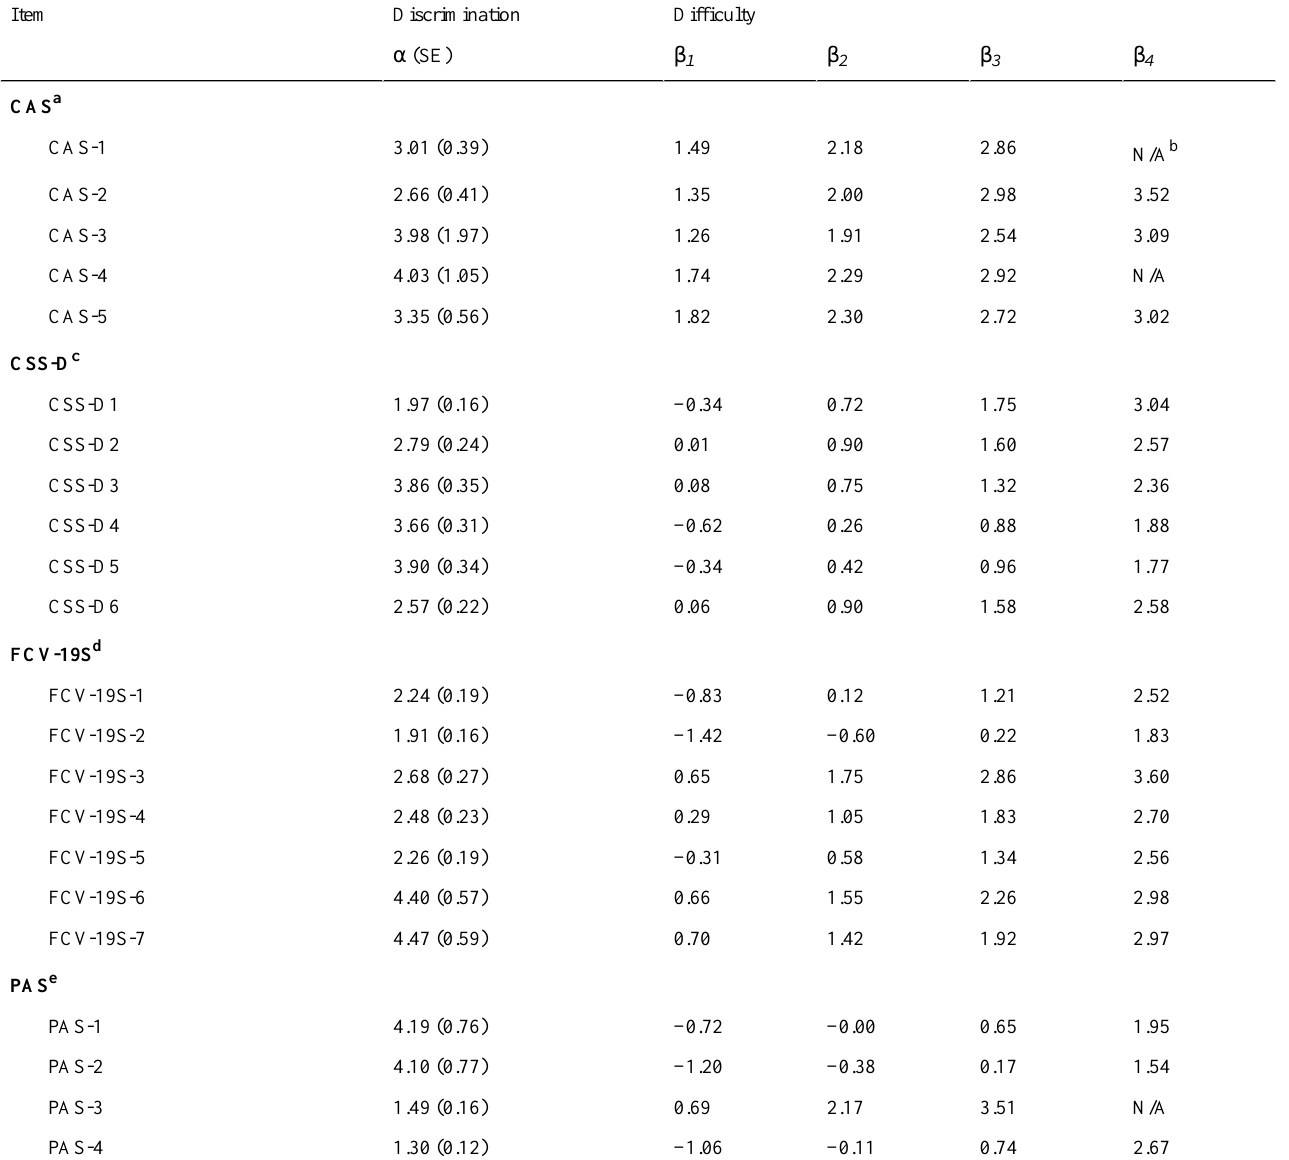
Table 6. Graded response model parameter estimates for the CAS, CSS-D, FCV-19S, and PAS (N=515).